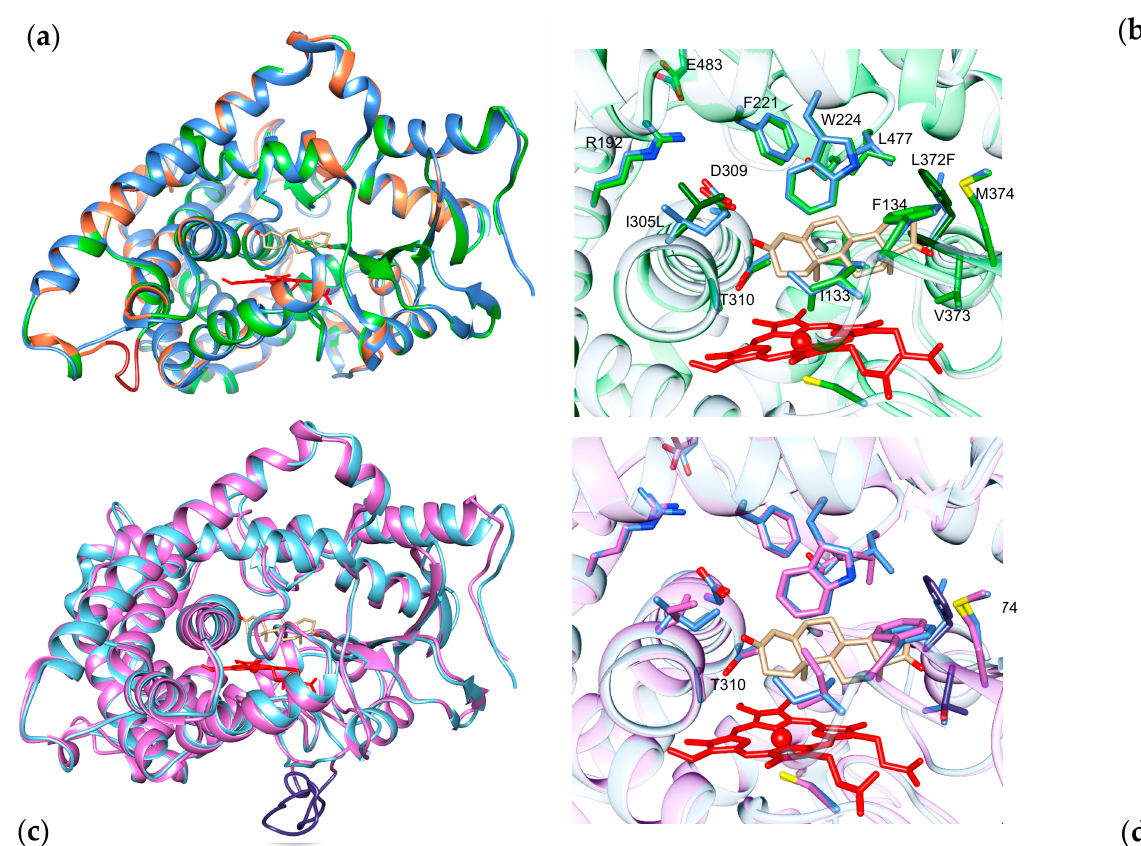
Figure 4. Homology models of evolutionarily old aromatase. ( a ) Homology model for aromatase from the invertebrate Branchiostoma floridae (green) superimposed onto the crystal structure of human aromatase (blue). The nonconserved regions are shown in orange, and the grey shadow shows the location of the insertion. ( b ) Zoomed-in view of the active site showing the conserved (green) and nonconserved residues (dark green) involved in substrate binding and catalysis. ( c ) Homology model for aromatase from the pufferfish Takifugu rubripes (magenta) superimposed to the crystal structure of human aromatase (blue). The grey shadow shows the location of the long insertion (violet). ( d ) Zoomed-in view of the active site showing the conserved (magenta) and nonconserved residues (dark purple) involved in substrate binding and catalysis. Heme is shown in red and the substrate androstenedione in light